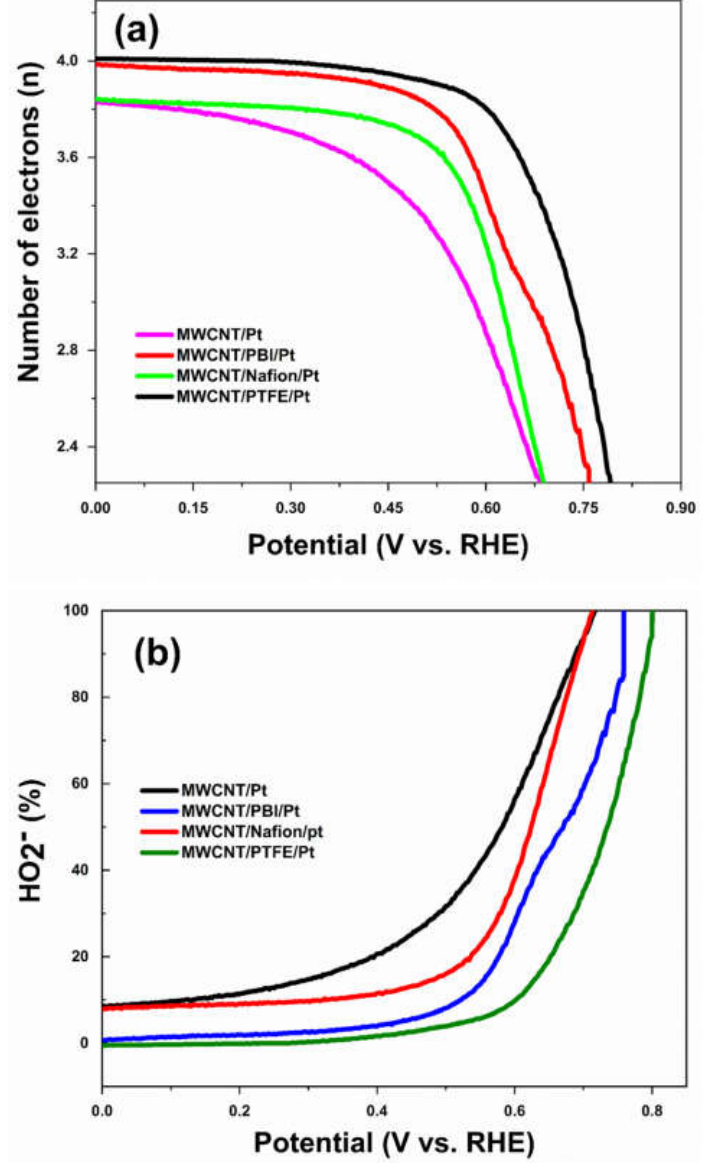
Figure 8. ( a ) The electron transfer number ( n ) of various electrodes and ( b ) the percentages (%) of HO 2− species of various electrocatalysts.